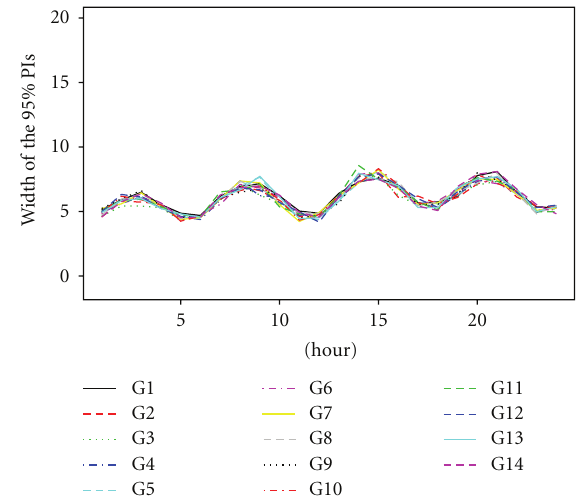
Figure 5: The width of the 95% pointwise predictive intervals (PIs) of the one-day-ahead prediction at 14 gauged sites using M2.